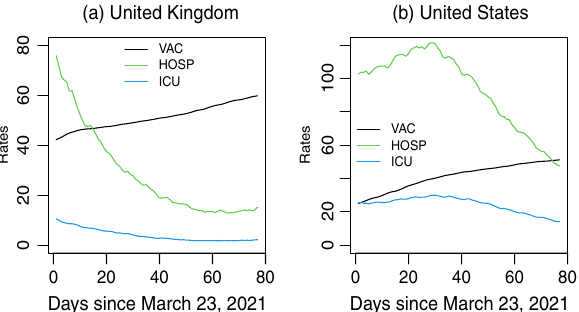
Figure 1. Percentage of people received at least one dose of vaccine (vaccinated), daily death per million (death), patients in hospitals per million (hospitalized), and patients in intensive care unit per million (ICU) since March 23,